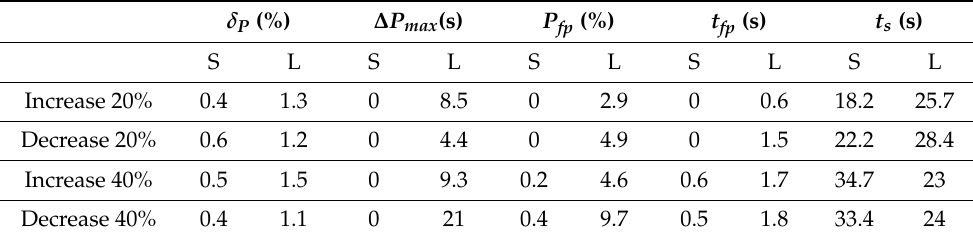
Table 3. Dynamic Response Index of Power